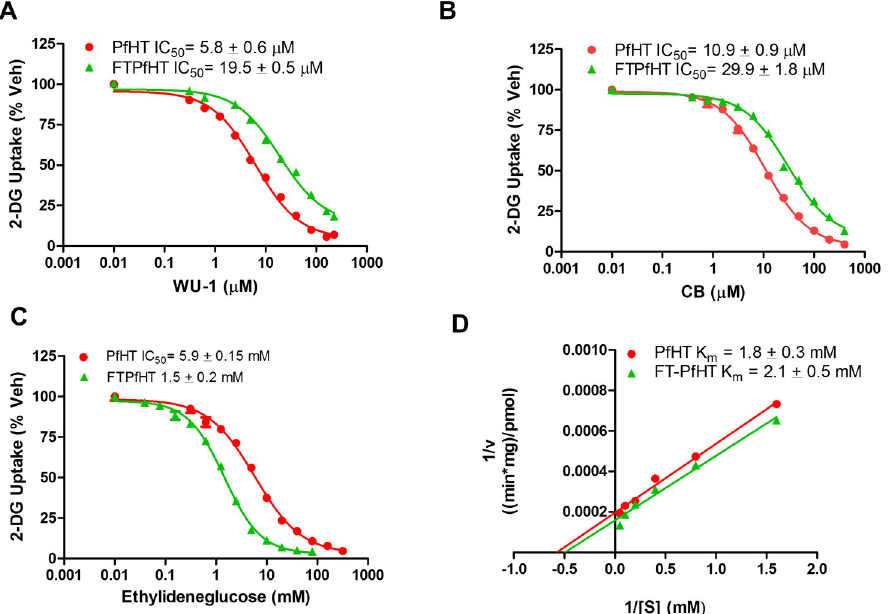
Fig 9. Effect of the FLAG tag on the inhibition of PfHT-mediated glucose uptake by WU-1, CB, and ethylideneglucose. A) Inhibition of 2-DG uptake by WU-1 in HEK293 cells overexpressing PfHT and FTPfHT. B) Inhibition of 2-DG uptake by the endofacial ligand cytochalasin B (CB) in HEK293 cells overexpressing PfHT and FT-PfHT. C) Inhibition of 2-DG uptake by the exofacial ligand ethylideneglucose in HEK293 cells overexpressing PfHT and FTPfHT. Data (Panels A-C) were fit by nonlinear regression analysis using GraphPad Prism 6.0 software to calculate the IC 50s . Data are expressed as means ± SEMs of three independent experiments performed in triplicate. D) Kinetic analysis showed that the FLAG-tag had little effect on the K m . 2-DG uptake (1 min) were measured in HEK293 cells overexpressing PfHT and FTPfHT at different 2-DG concentrations. K m values were determined from nonlinear regression analysis using GraphPad Prism 6.0. Data are plotted in double-reciprocal form and expressed as the means ± SEMs of three independent experiments performed in